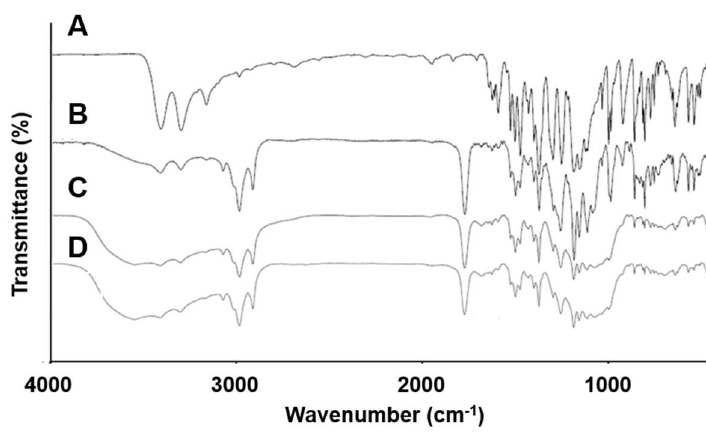
Figure 8. FT-IR spectra of ( A ) pure CLC, ( B ) F5 (CLC + PC), ( C ) F10 (CLC + PC + Neusilin ® US2), and ( D ) F11 (CLC + PC + Neusilin ® US2 + CCS).